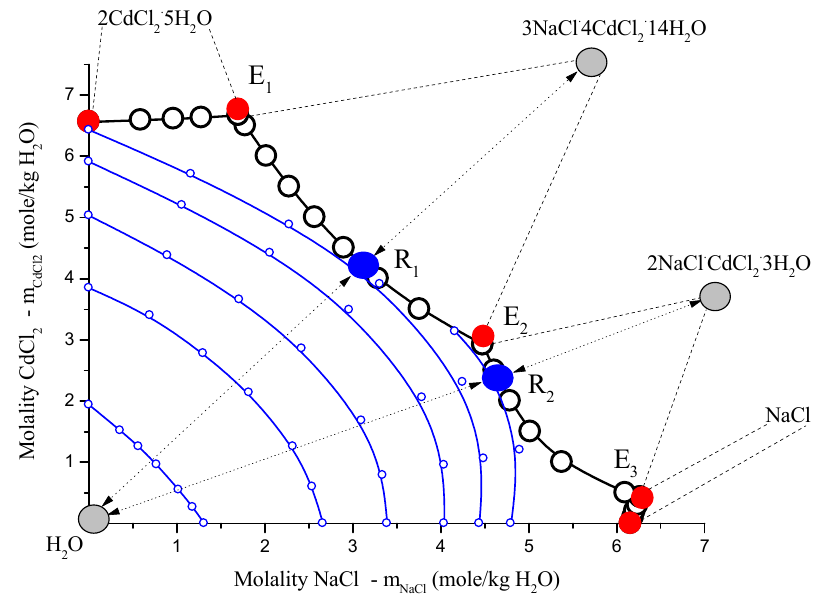
Figure 3. Solubility diagrams in ternary NaCl–CdCl 2 –H 2 O system at 25 ◦ C in rectangular Schreine- makers concentration triangle in the salt molalities: open black circles, calculated by Extended Pitzer’s Method [16]; red solid circles, non-variant experimental data [16,17]; blue solid points (R i ) , solubility diagram points type Van Rijn points in fusibility diagrams [17]; little open blue points, H 2 O = const ); gray points, figurative points of coexisting equilibrium vapor (H isopotentials ( µ H 2 O solid compounds phases c and 3 NaCl · 4 CdCl 2 · 14 H 2 O ; E i , eutonics [17,18]; dots with two-directed arrows are nodes: vapor (v) , saturated solutions (R i ), and solid compounds (s)